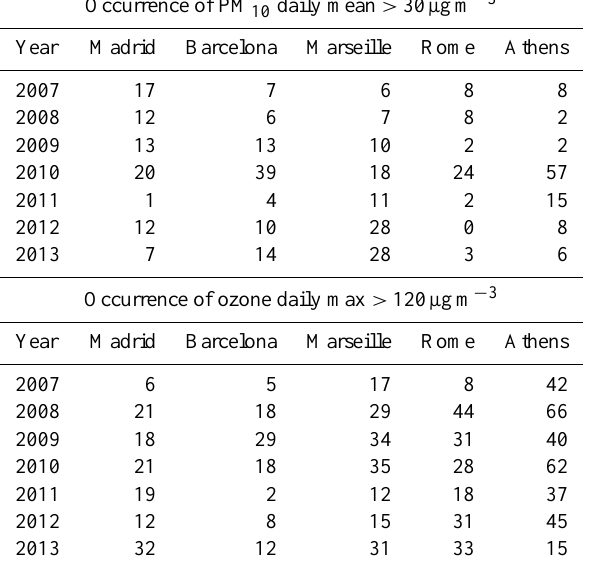
Table 3. Number of days in June, July and August when (i) surface daily mean concentrations of PM 10 exceed the threshold value of 30µgm − 3 , and (ii) surface daily maximum concentrations of ozone exceeds 120µgm − 3 . Data are extracted from the model cell corre- sponding to the location.